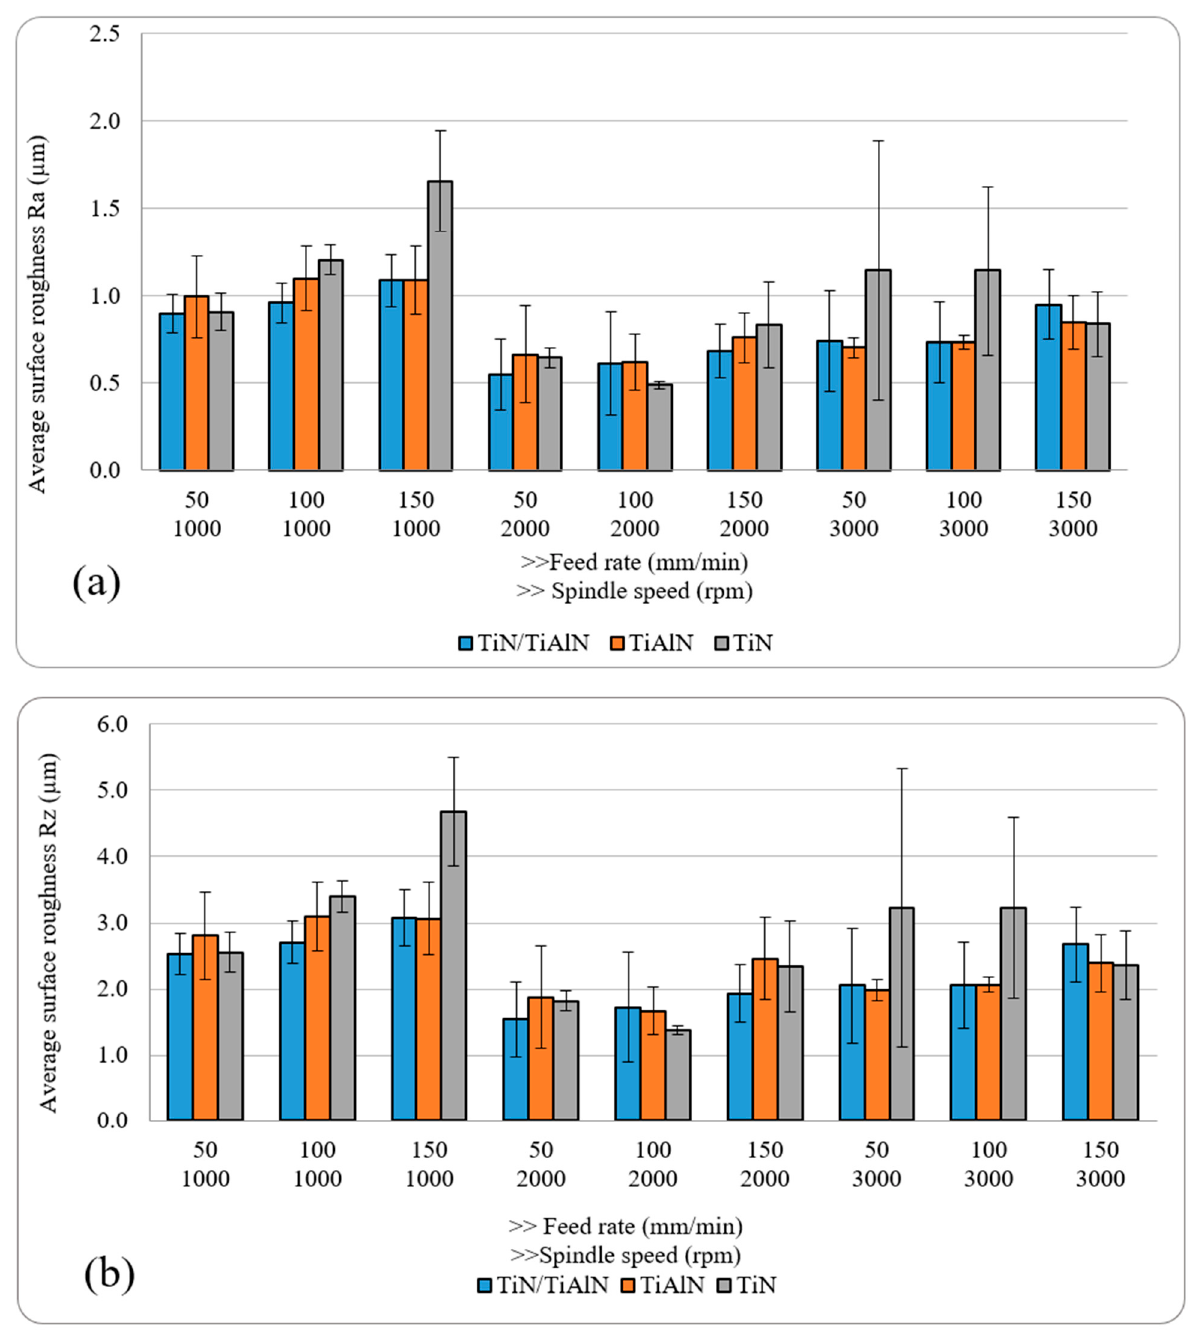
Figure 3. Average hole surface roughness: ( a ) R a ; ( b ) R z .